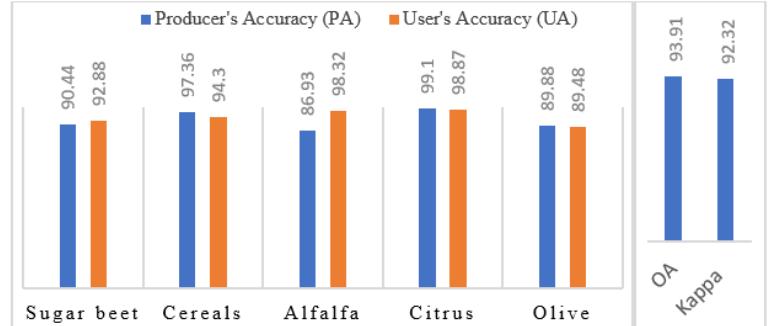
Figure 8. Accuracy assessment of SVM classification.